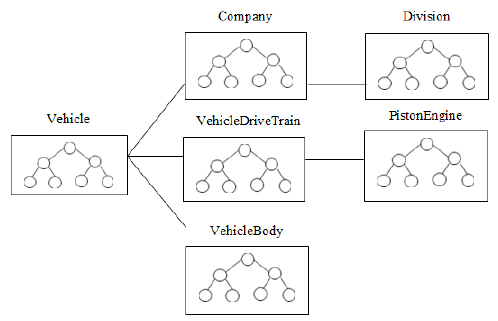
Figure 8 . Signature files hierarchy and